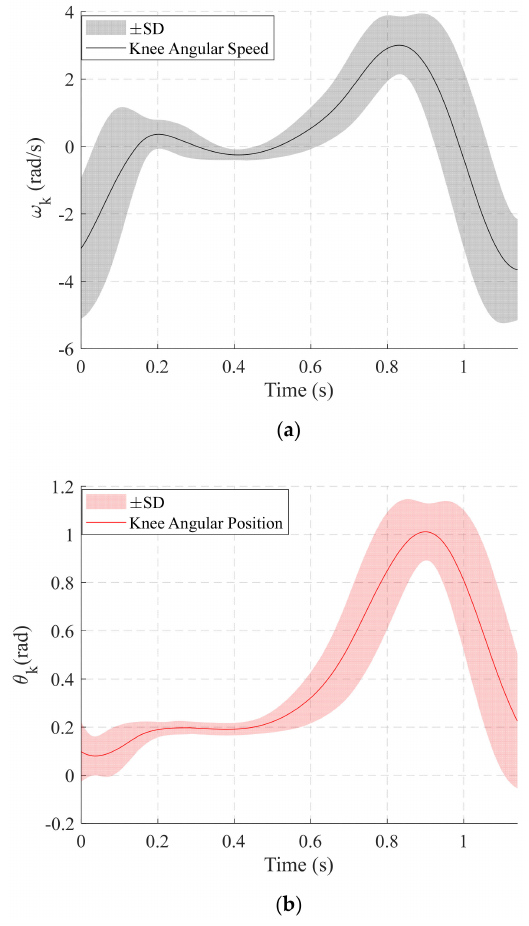
Figure 6. Knee kinematics in the sagittal plane for 50 consecutive steps of a normal subject with a self-selected walking speed. ( a ) The average of knee angular speed is shown in solid black and standard deviation is in gray. ( b ) The average of knee angular position is shown in solid red and standard deviation is in